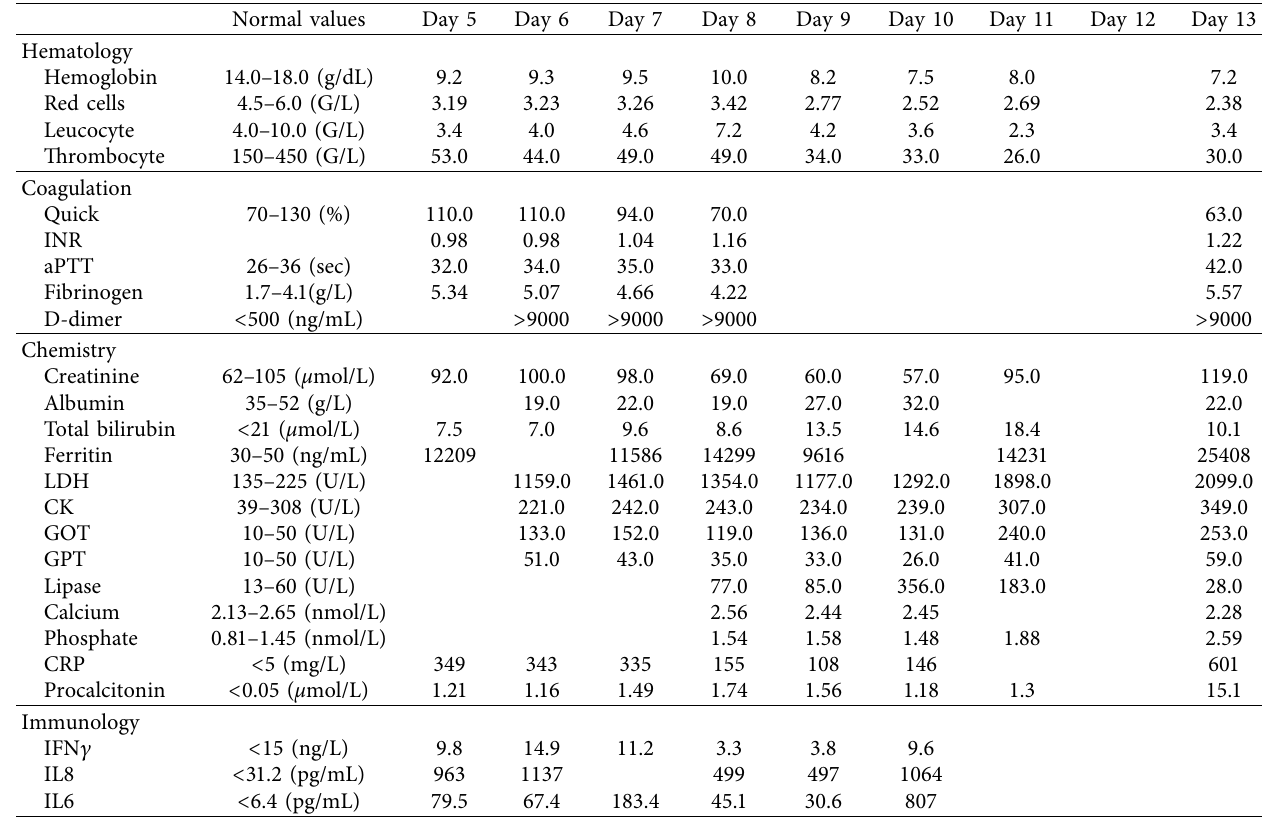
Figure 1: H-score calculator (H-score calculator redraw ([13])): the probability of HLH increases with the increase of score. The best cutoff value was 169, which corresponds to an accuracy of 90% (sensitivity of 93%, specificity of 86%). In this case report, patient presented a H- index of 229 points (96–99% of Table 1: Laboratory characteristics.